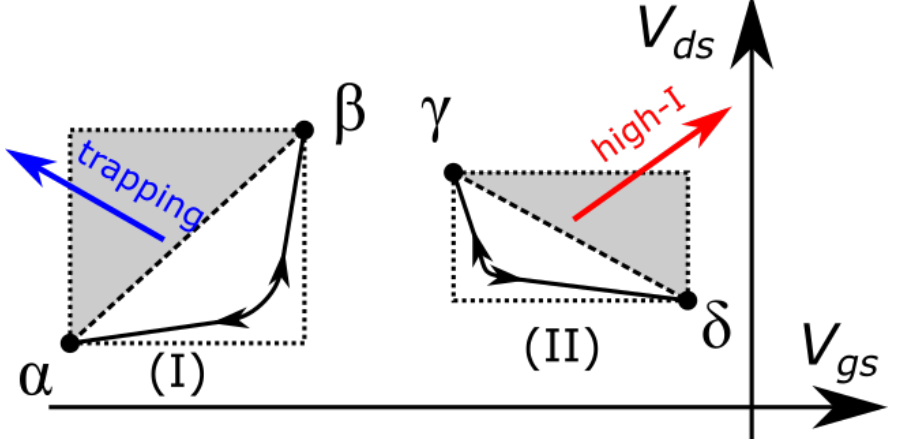
Figure 6. Graphical representation of two main cases (I) and (II) for the transitions between two quiescent voltage points. The showed trajectories allow to avoid exciting spurious fast charge capture and non-reversible high-current effects.